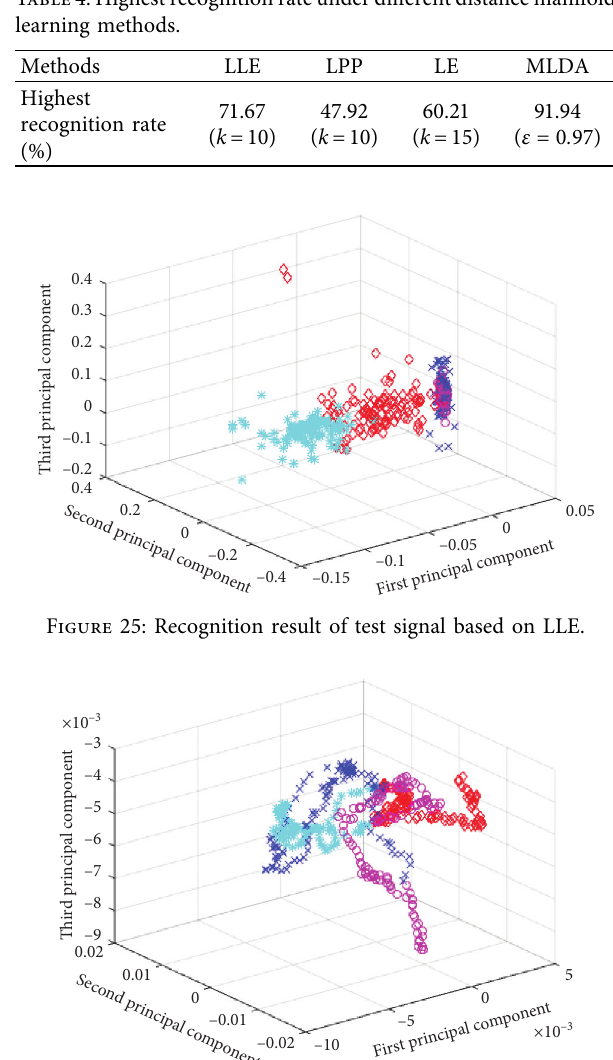
Figure 26: Recognition result of test signal based on LPP.